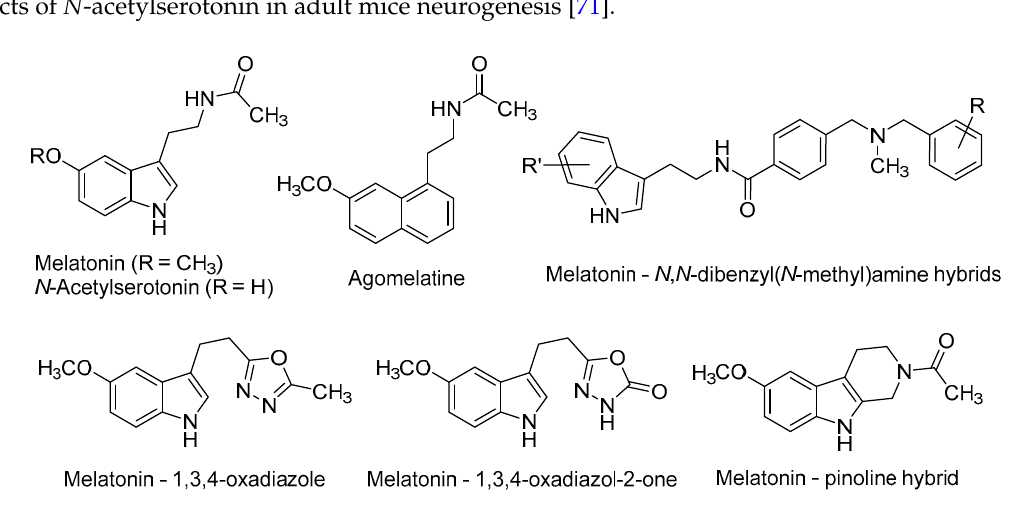
Figure 2. Neurogenic agents related to melatonin.